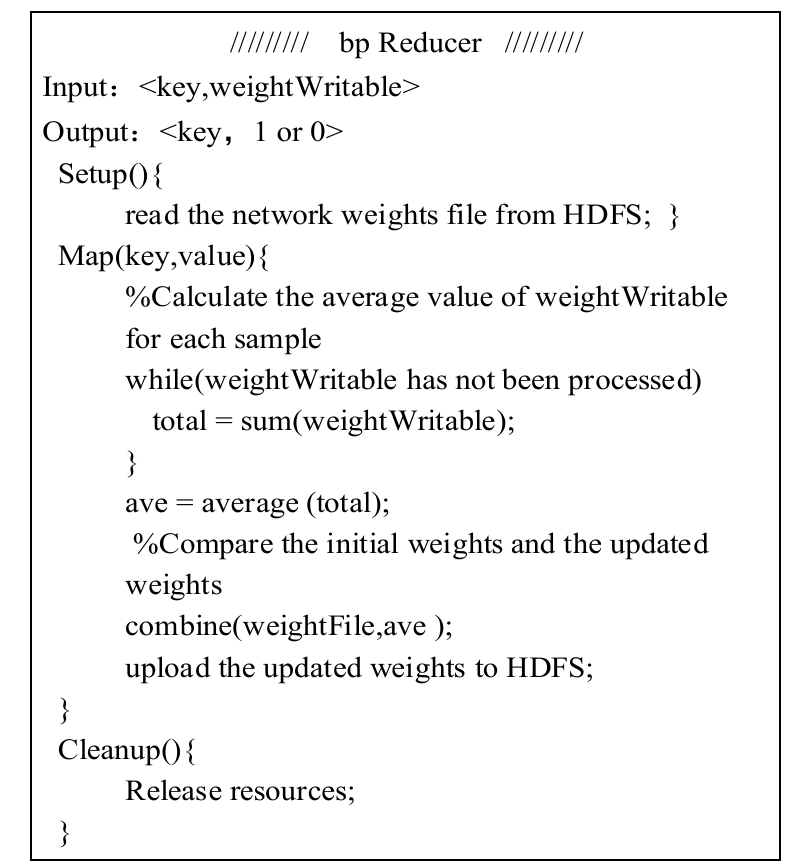
Figure 11. The pseudo code of Reduce stage.